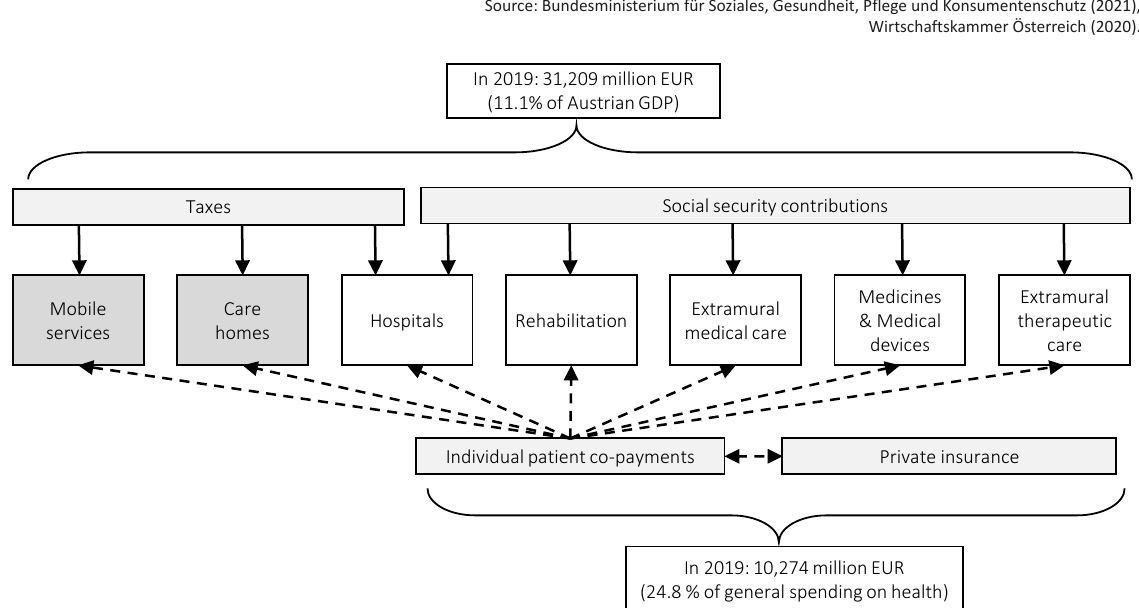
Figure 4. Financing sources of the Austrian healthcare system